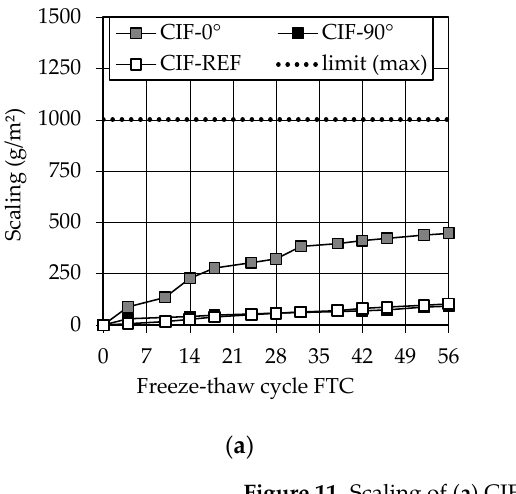
of (a) specimens exposed to water (CIF) and (b) specimens exposed to de-icing salt (CDF).